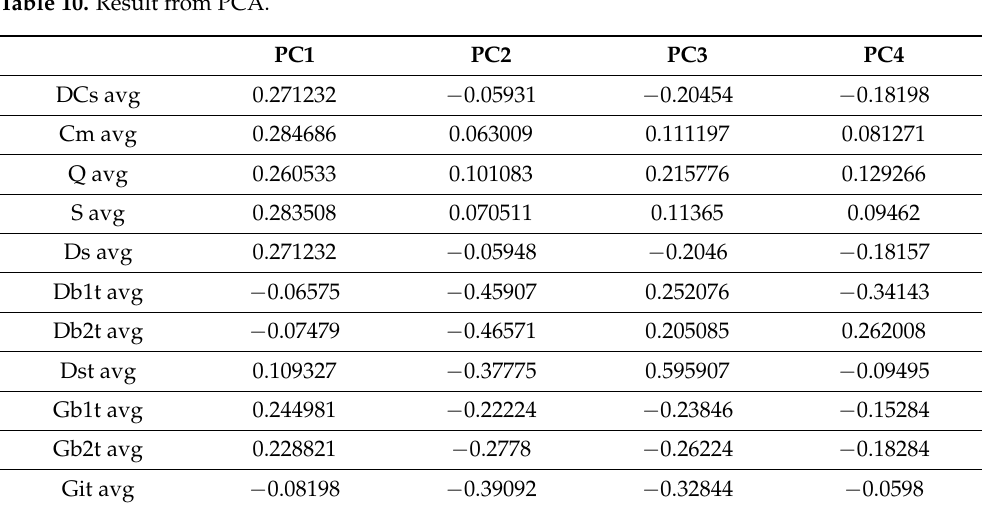
Table 10. Result from